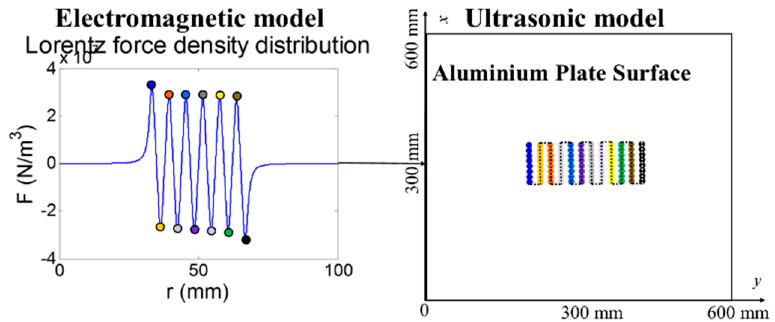
Figure 12. On the surface plane of the material, the transformation between the EM and US models. Reproduced with permission from [18], Elsevier, 2017.